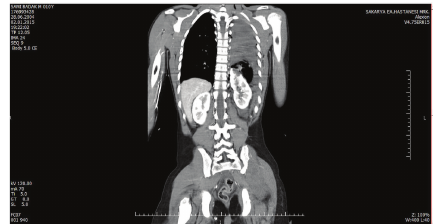
Figure 1: CT scan imaging of left diaphragmatic rupture and left intrathoracic